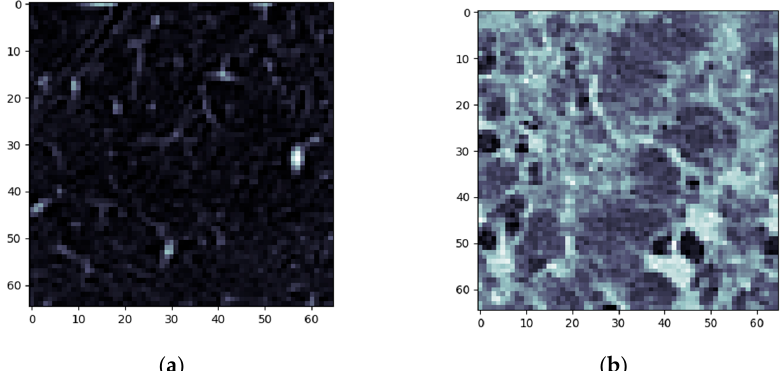
Figure 4. Algorithm step 1—sample selection ( a ) Normal sample ( b ) DILD (IFP) sample.